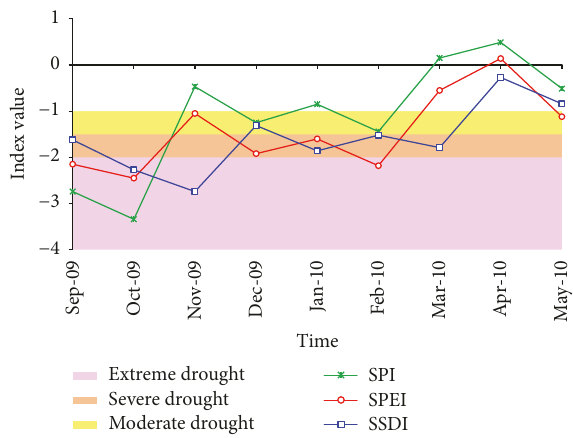
Figure 11: Compared SSDI with SPI and SPEI in Kunming city from September 2009 to May 2010.